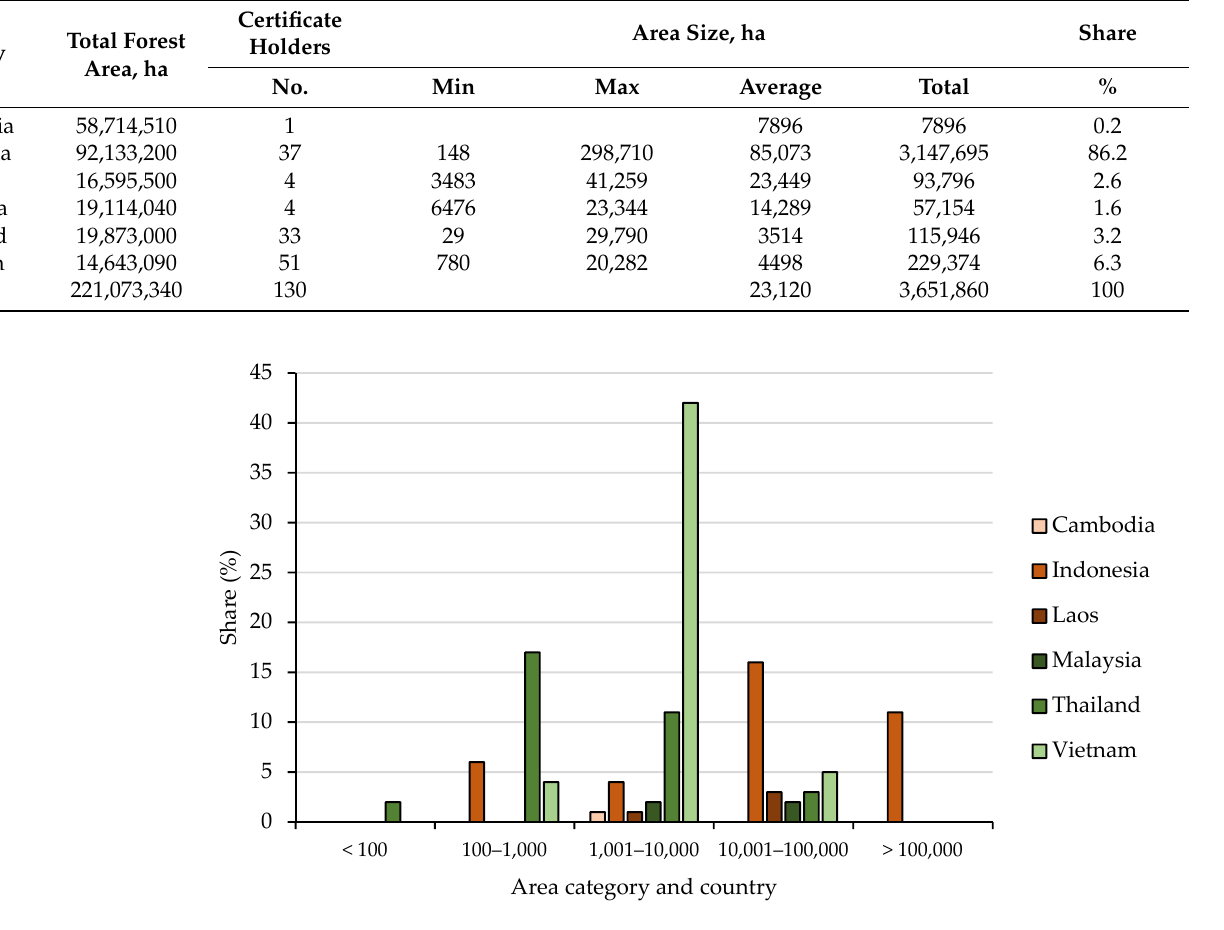
Figure 1. Certified areas in different size classes (ha) per country.